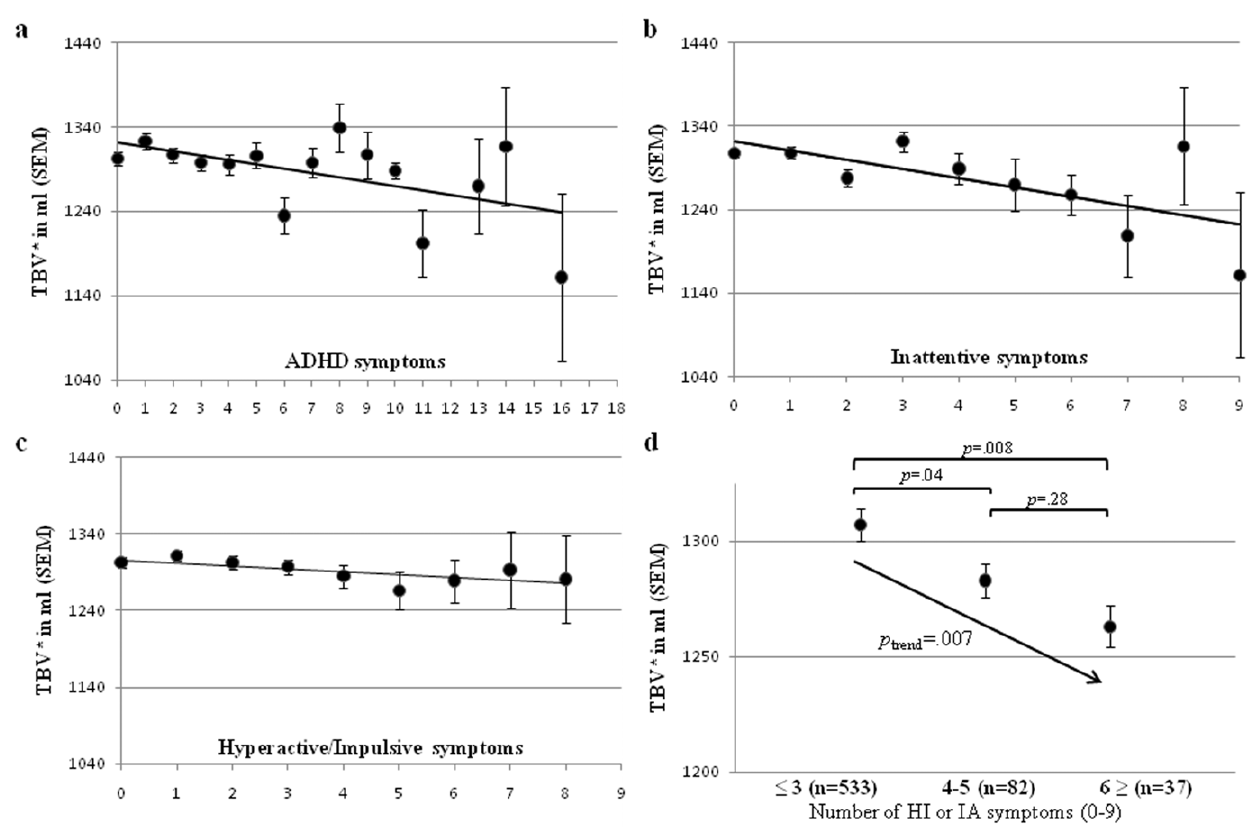
Figure 1. Distribution of total brain volume (TBV) and adult self-reported ADHD symptoms in a healthy sample (n=652). ( a ) TBV is associated with the total number of self-reported ADHD symptoms. Of the two ADHD symptom domains, mainly the attentive domain contributes to TBV: ( b ) inattentive symptoms ( b = 2 .09, p nominal =.007, p empirical =.013), and ( c ) hyperactive/impulsive symptoms ( b = 2 .06, p nominal =.064, p emperical =.123). ( d ) Total brain volume across groups based on the number of self-reported ADHD symptoms. The group with 3 or less self-reported symptoms differed from the intermediate group and from the group with a number of ADHD symptoms corresponding to the ADHD diagnosis ( $ 6 in either of the two domains). *Total brain volume was adjusted for age, gender and field strength.